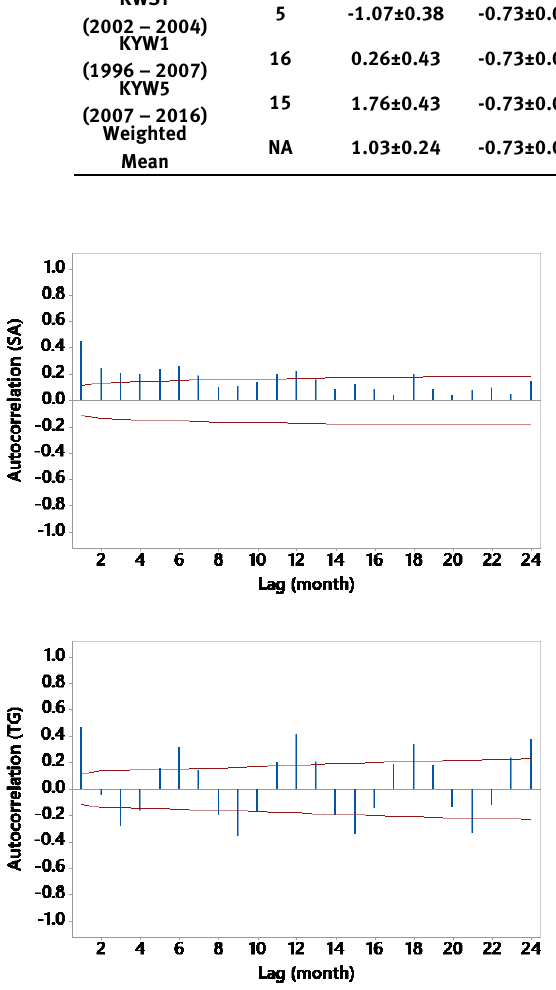
Fig. 4. Correlelograms of the SA and TG residual series. Confidence intervals (95%) are in